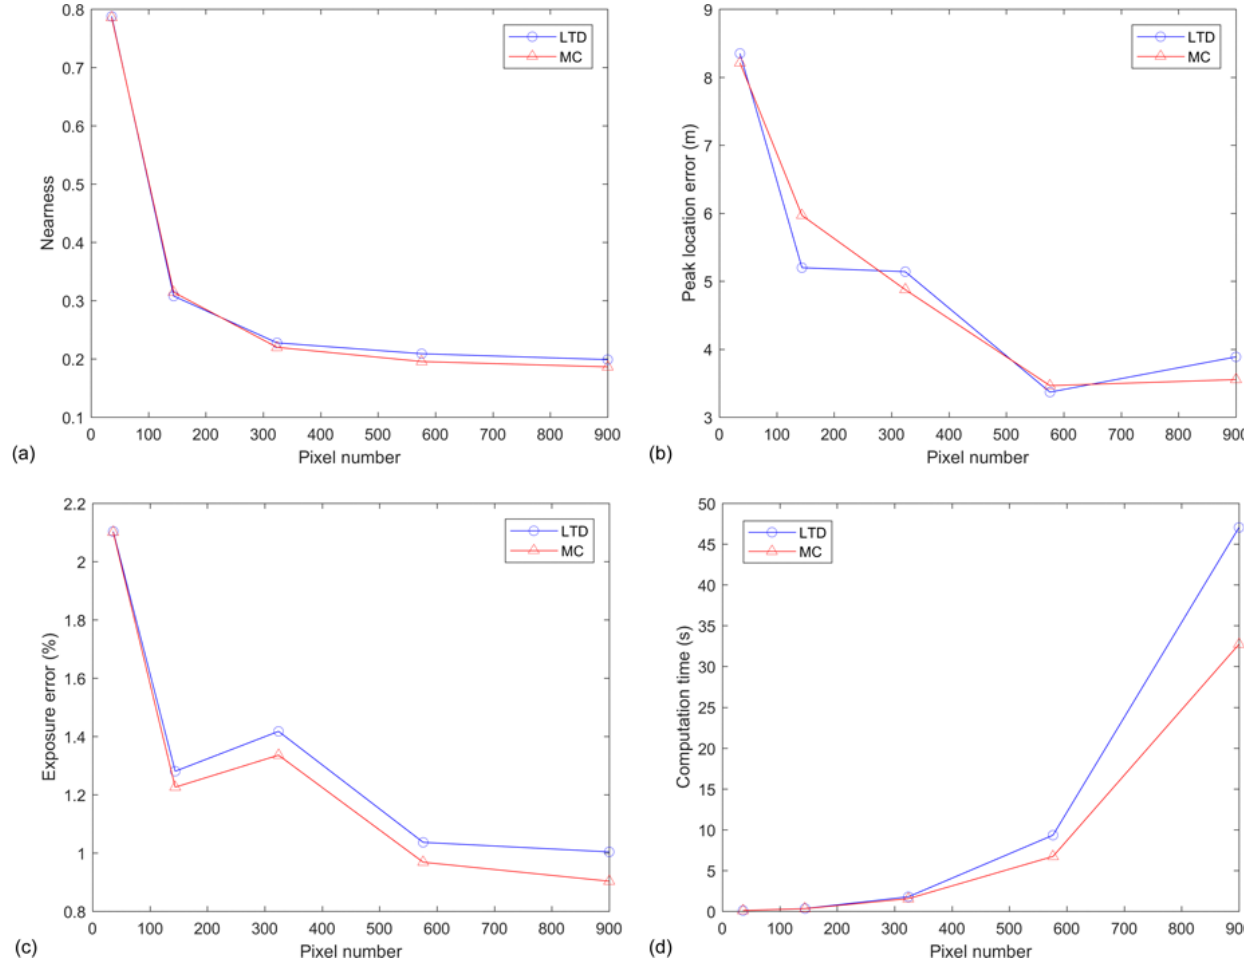
Figure 5. The change in (a) nearness, (b) peak location error, (c) exposure error percentage, and (d) computation time with respect to the pixel